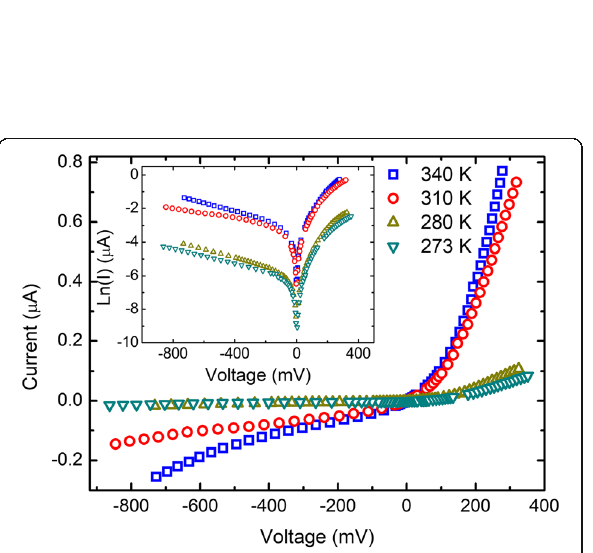
Fig. 2 Current-voltage characteristics of Au-ReSe2-Au junctions at 273 K, 280 K, 310 K, and 340